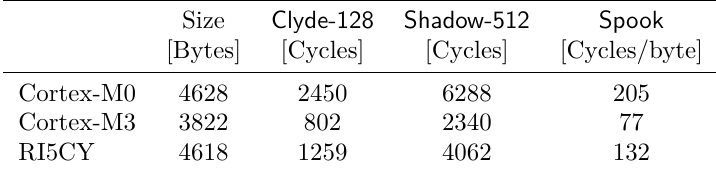
Table 8: Speed-optimized performances on embedded platforms